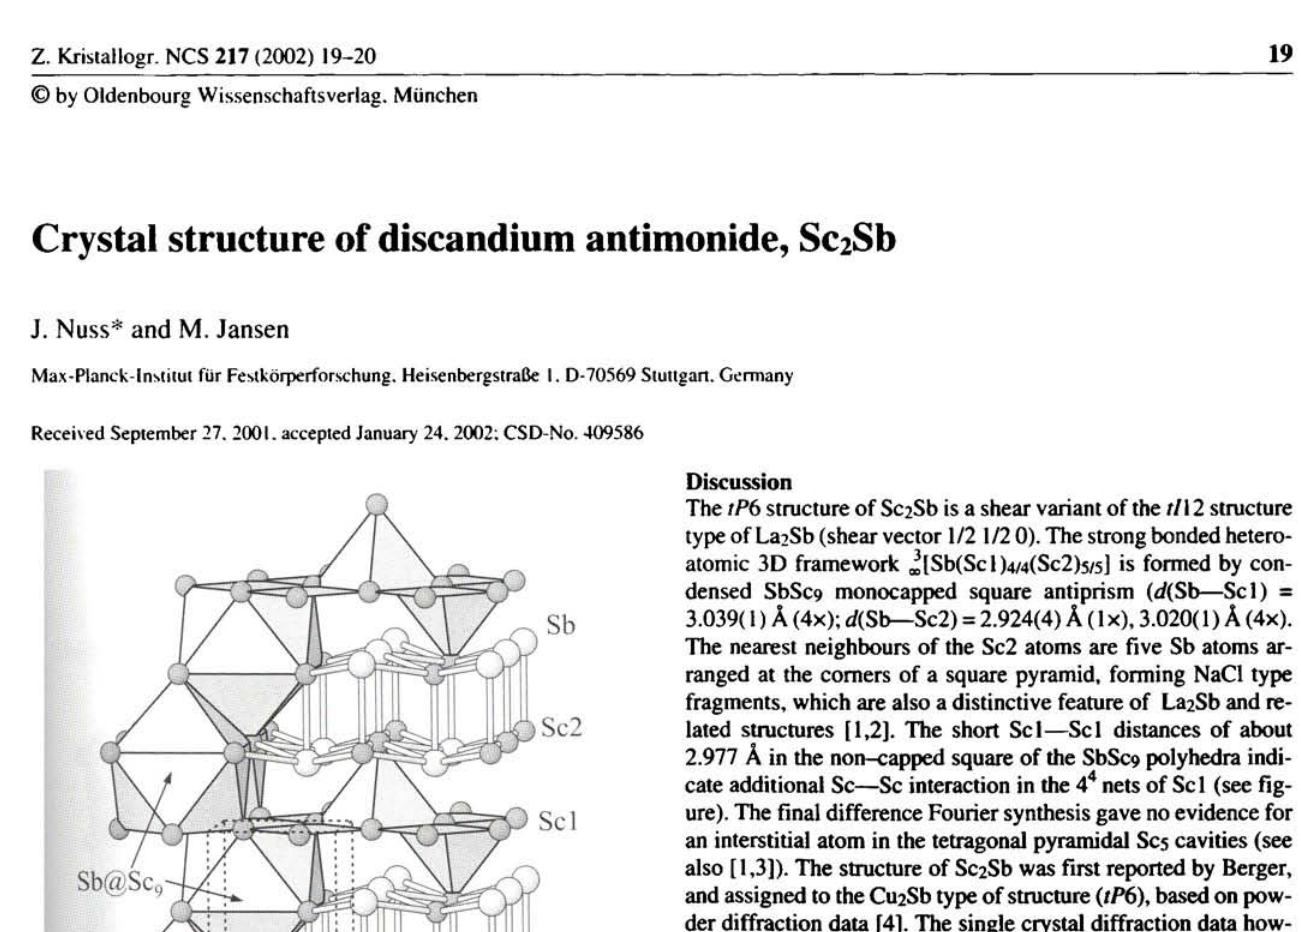
Table 1. Data collection and handling.